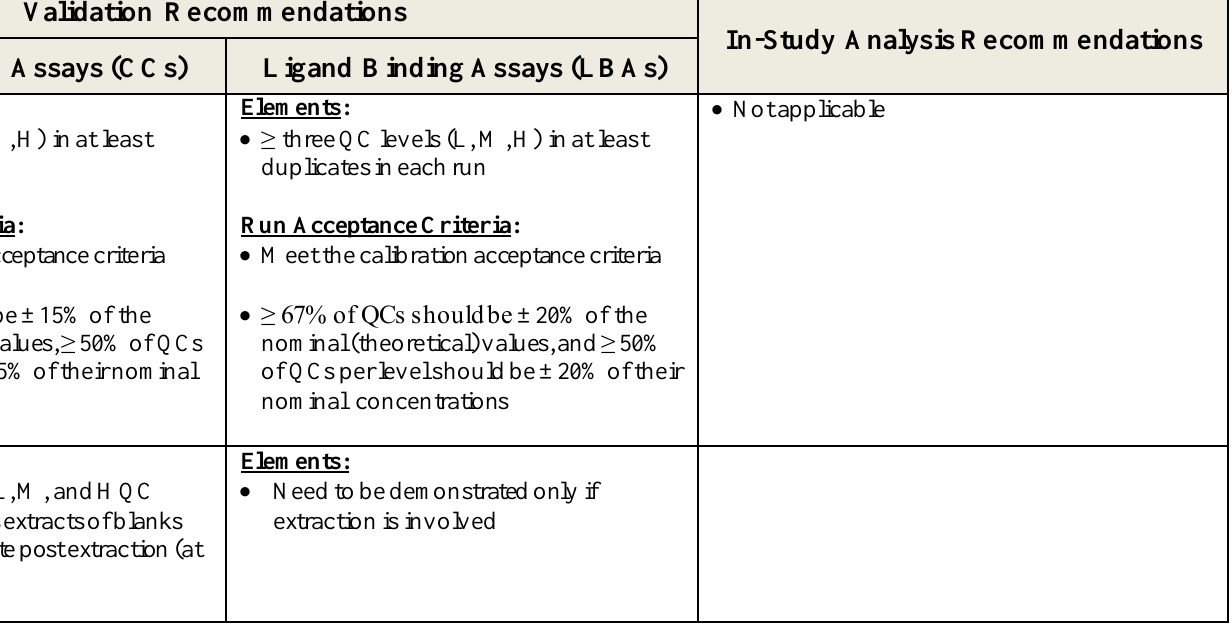
Table 1 continued. Recommendations and Acceptance Criteria for Bioanalytical Method Validation and In-Study Conduct